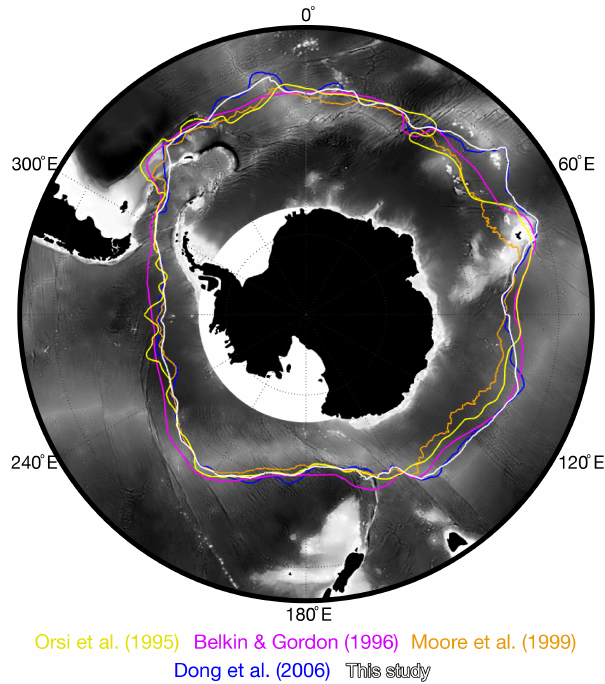
Figure 6. The climatological position of the PF in this and pre- vious studies overlain on bottom topography obtained from the National Geophysical Data Center (www.ngdc.noaa.gov/mgg/dat/ misc/predicted_seafloor_topography/TOPO/), where light (dark) shading indicates shallow (deep)